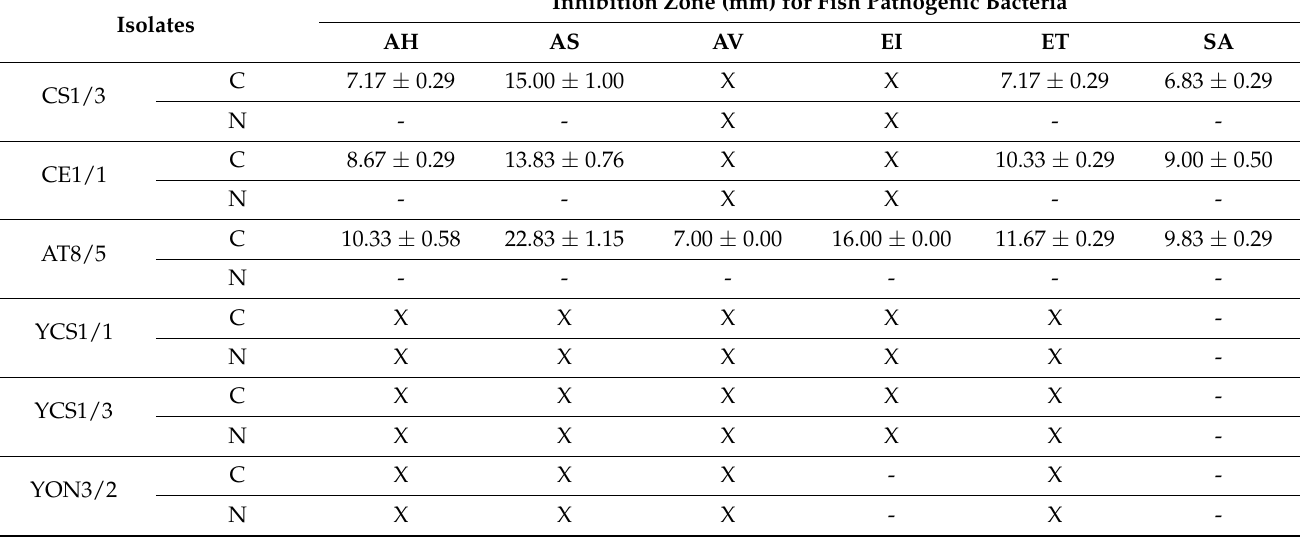
Table 5. Determination of the inhibitory factors of selected probiotic isolates against fish pathogens, as determined by agar well diffusion methods (Mean ±